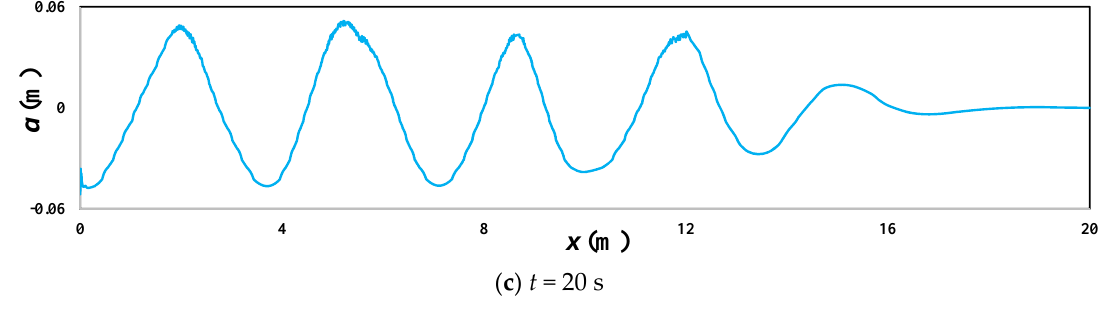
Figure 4. The free surface time series at ( a ) x = 2 m and ( b ) x = 6 m, and ( c ) the waveform at t = 20 s.